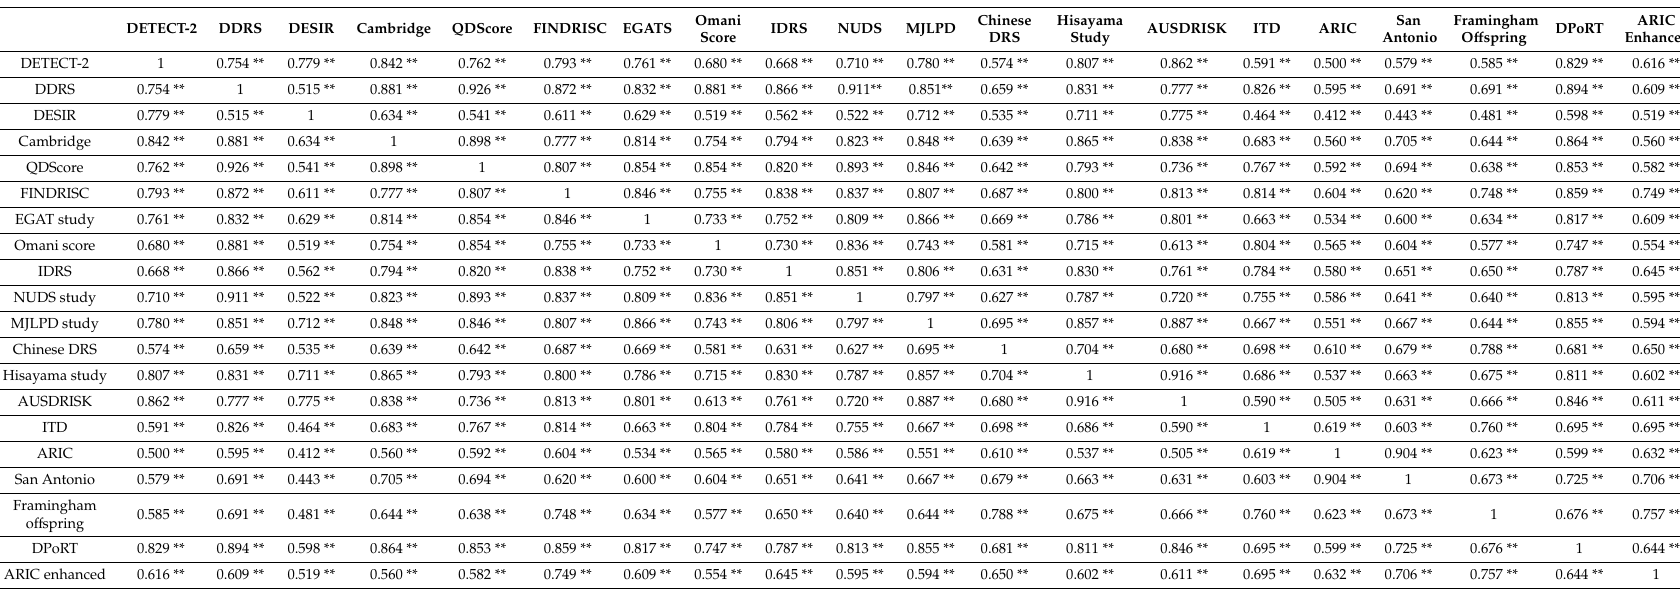
Table 4. Correlation between models included for predicting risk of type 2